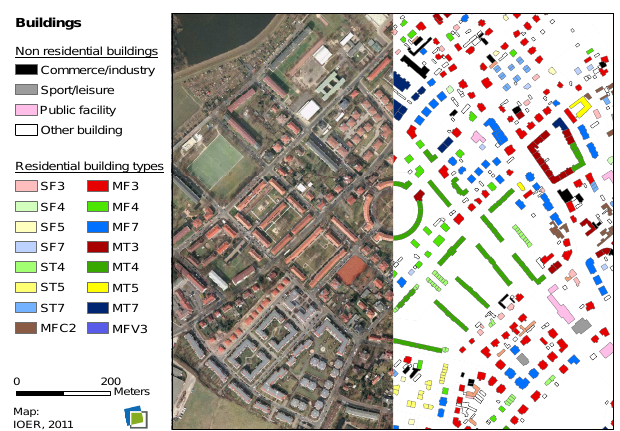
Fig. 7. Example of aerial photograph (left side) and detected build- ing types at the river Elbe area (right side); data sources: Build- ing layer of the Digital City Map (DSK 500), Aerial photographs 2007/2009: Dresden City